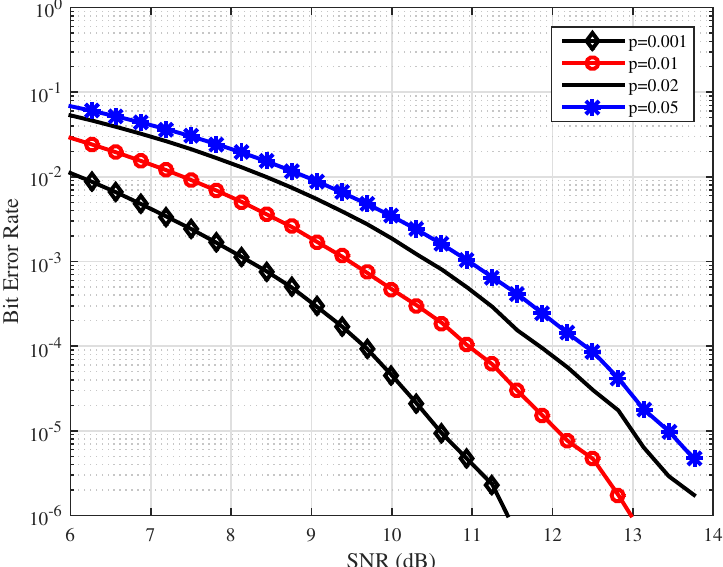
Figure 13. BER performance with various impulsive noise